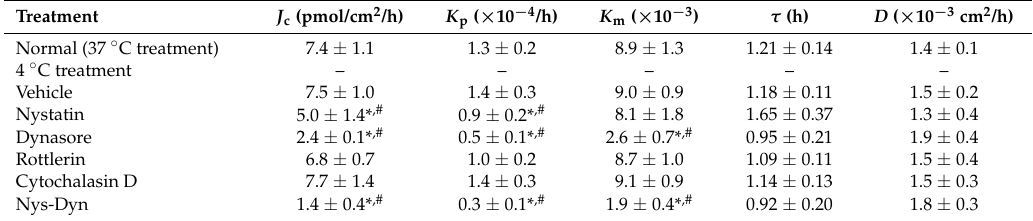
Table 2. Pharmacokinetic parameters for IND-NPs penetration in the ileum treated under cold (4 ◦ C) temperature conditions or with endocytosis